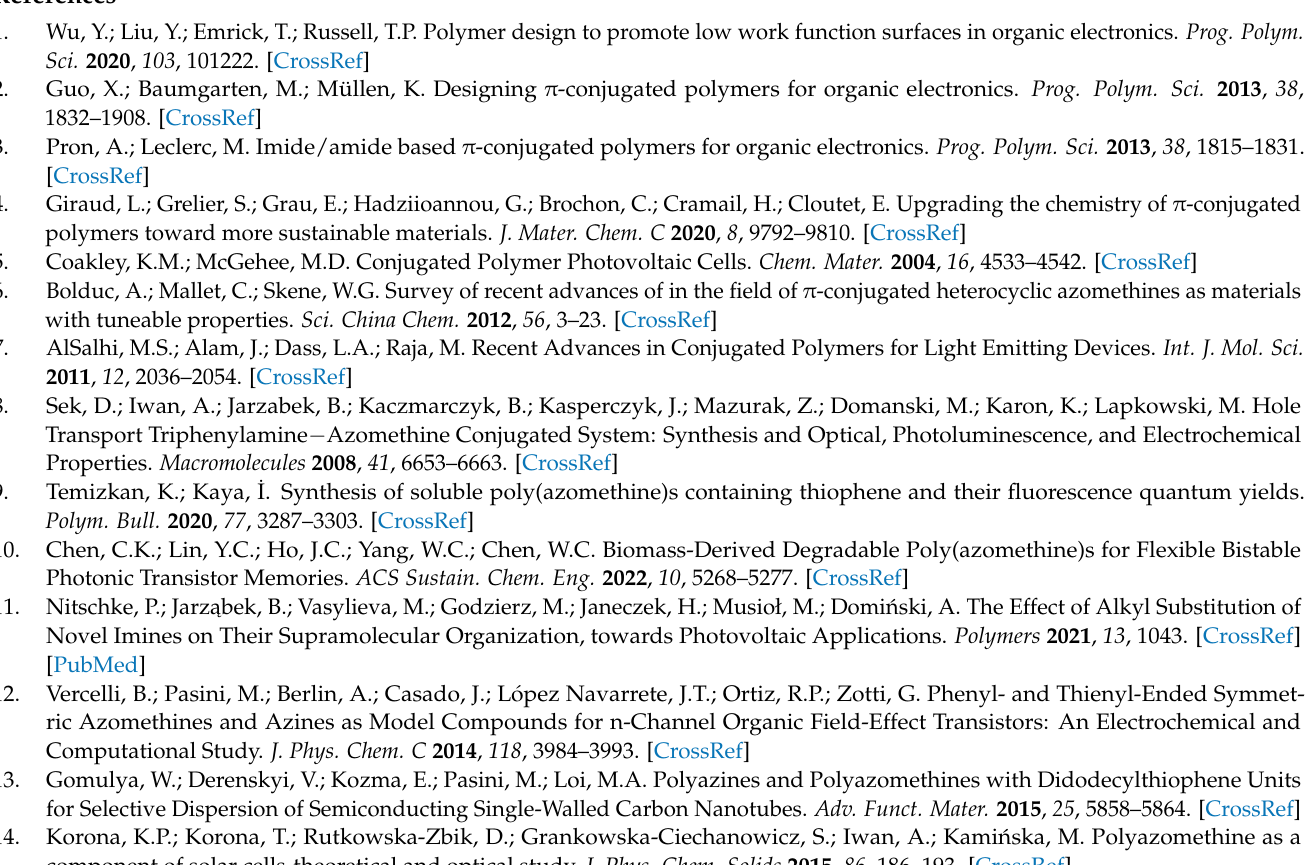
Figure S3: Comparative UV-vis absorption spectra of P1 in CHCl 3 and DMF solutions;